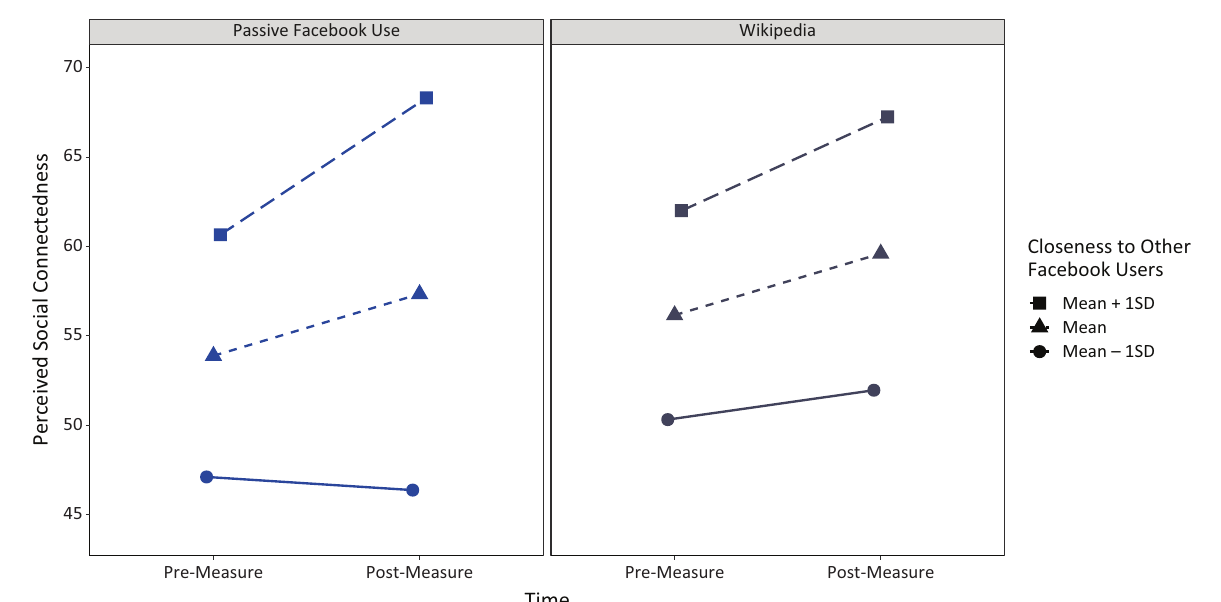
Figure 3. The plotted simple slopes for the three‐way interaction effect between Closeness to Other Facebook Users, Facebook Use, and Time on Perceived Social Connectedness. Note: A regression equation was created, and the mean and standard deviation for Closeness to Other Facebook Users were used to predict values of perceived social connected‐ ness at three different levels of Closeness to Other Facebook Users (as recommended by Aiken & West,